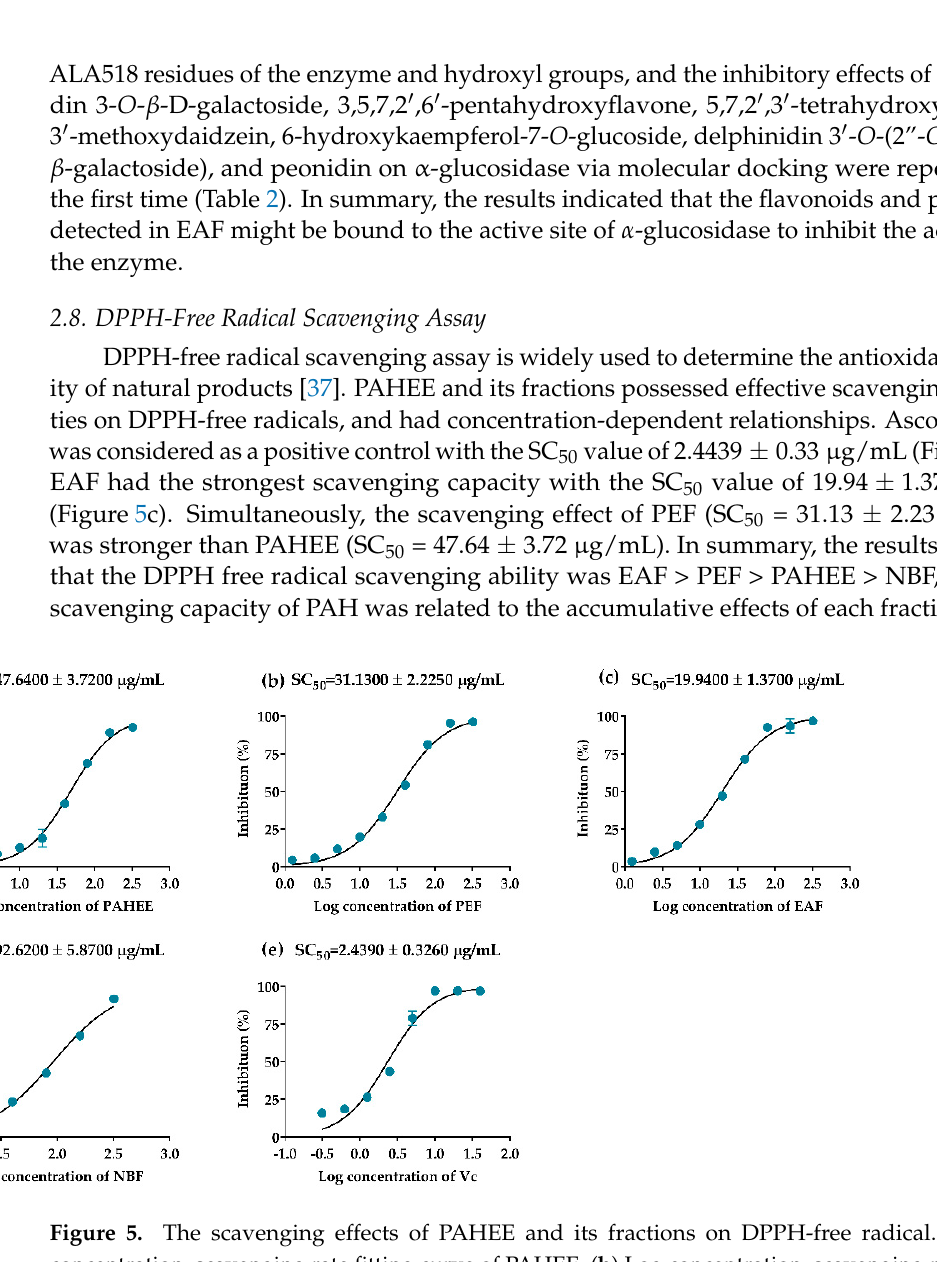
Table 3. Antioxidant activities of PAHEE and its fractions via assays for DPPH, ABTS, and FRAP. Samples